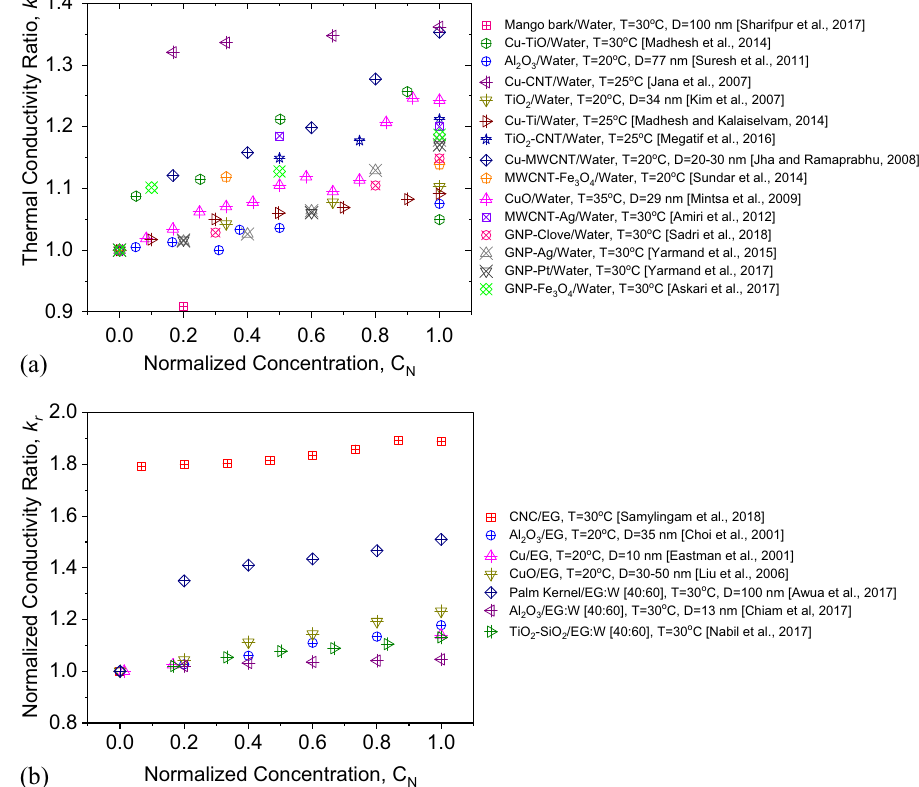
Figure 3: E ff ect of types of nanoparticles: ( a ) water ( b ) EG and W:EG